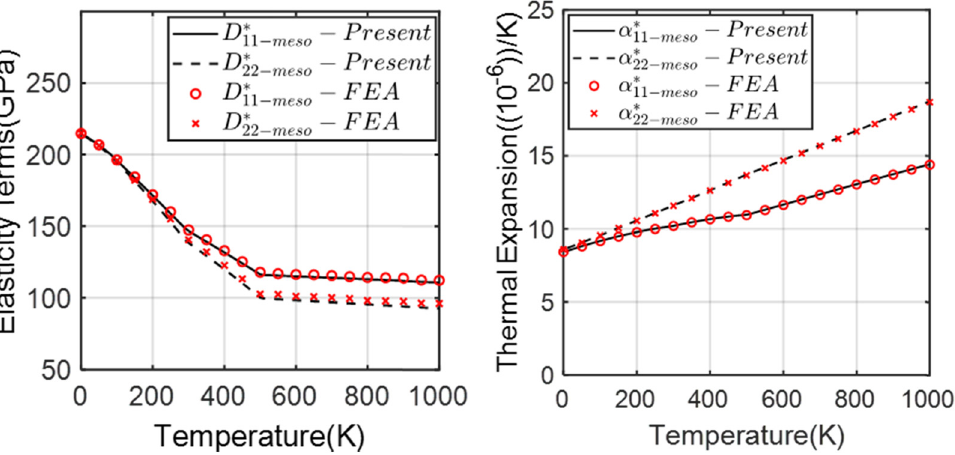
Figure 10: Comparison of homogenized main diagonal elasticity terms ( Left ) and thermal expansion coe ffi cients ( Right ) generated by LEHT and in - house FEA with v 0.72 f = at